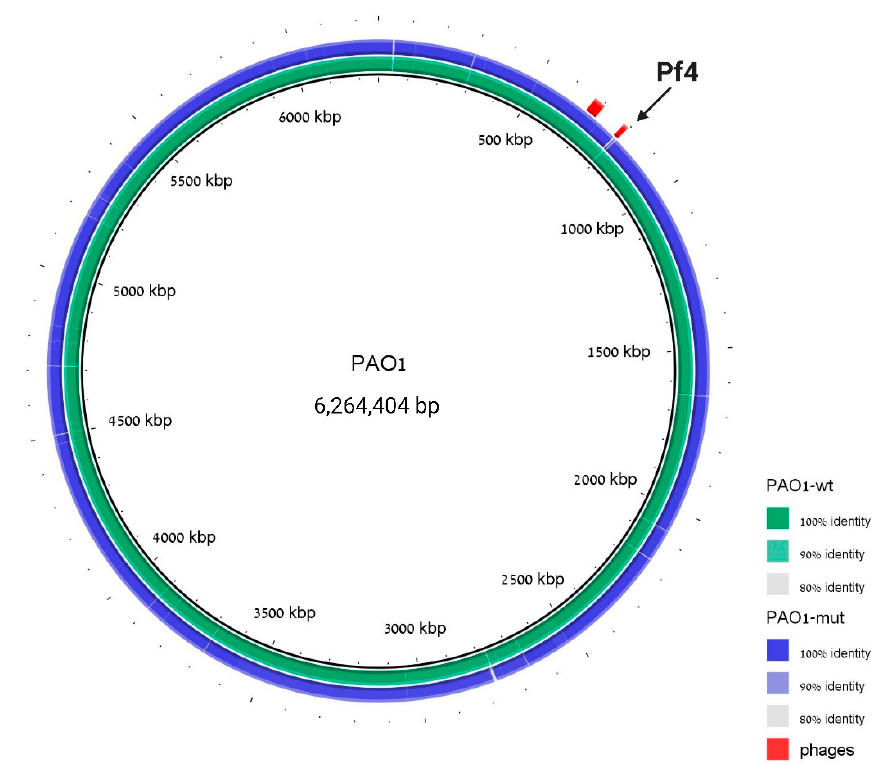
Figure 3. The ∆ Pf4 strain differs from WT in the Pf4 region. Genomic alignment with PAO1 strain is used as a reference, PAO1 WT sequence assembly is indicated in green, and ∆ Pf4 strain sequence assembly is indicated in blue. Prophage regions are labeled in red; coordinates are taken from PHASTER analysis to the reference PAO1 strain. The cured region is marked with an arrow. We note that there is a difference between our laboratory WT strain and the reference strain around region 2800 bp, but this difference is identical in the Pf4-mutant